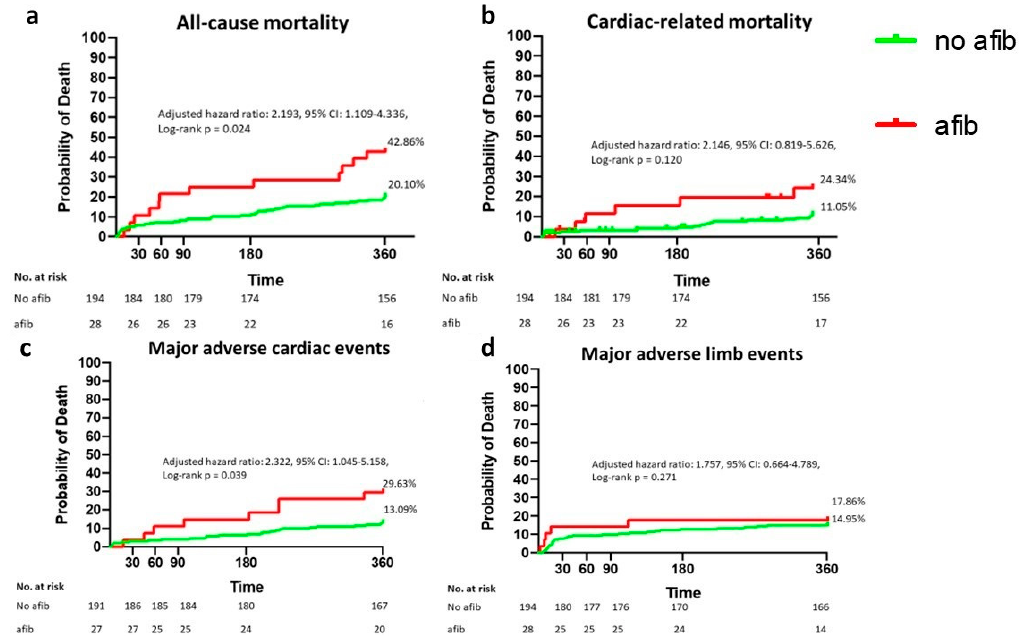
Figure 1. Patients with atrial fibrillation (red line) had significantly greater ratios of all-cause ( a ), cardiac-related mortality ( b ) and major adverse cardiac events ( c ) than patients without atrial fibrillation (green line). Major adverse limb events ( d ) were not significantly different between the two groups.